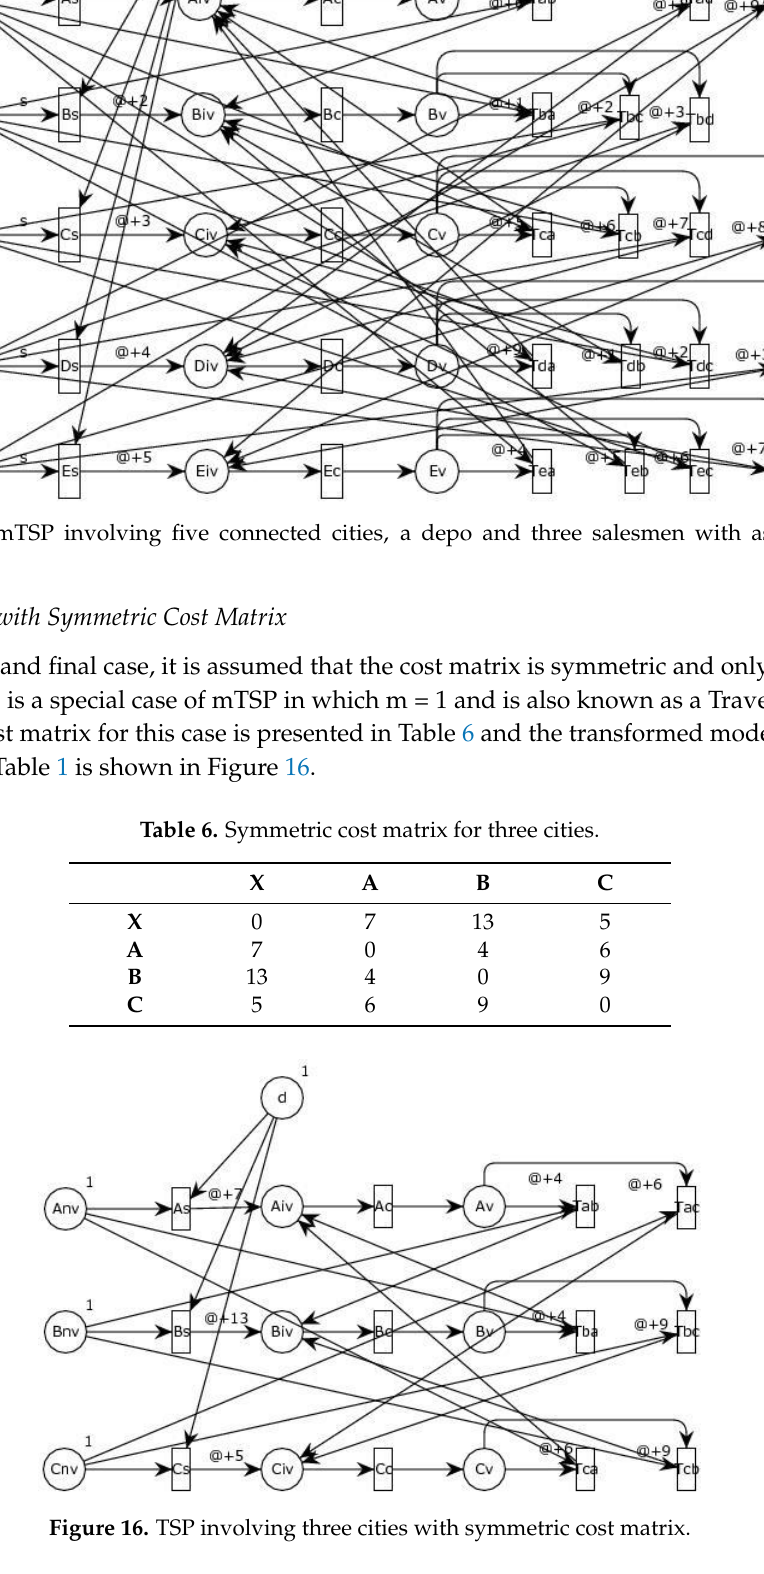
Table 5. Simulation Results. Optimization Objective